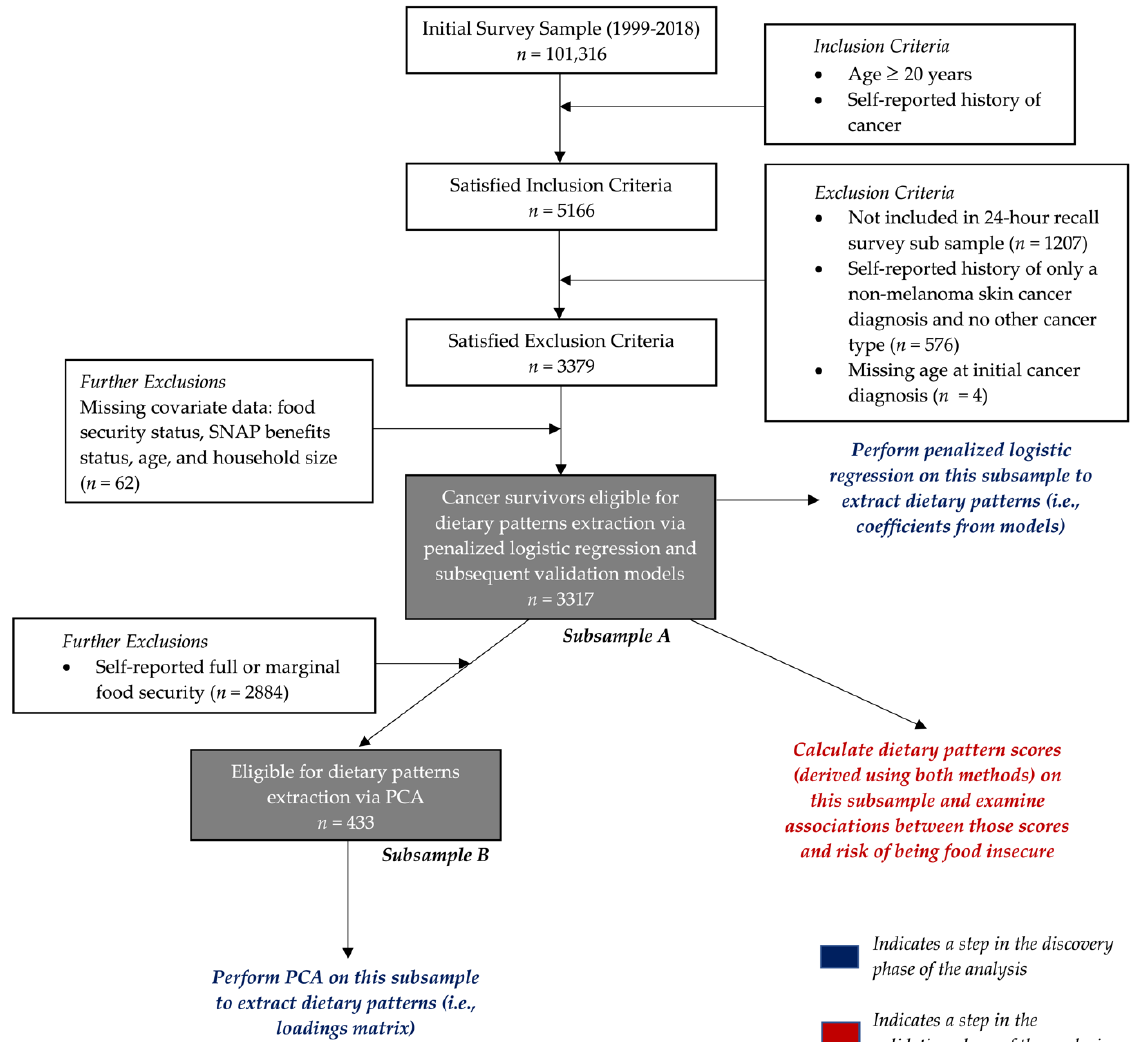
Figure 1. Study sample flow chart detailing the sample selection process and the analytical strategy. Subsamples A and B are periodically referred to in the text.